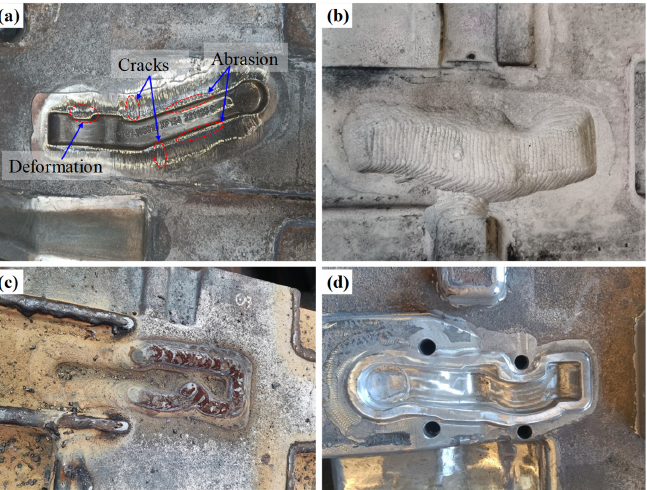
Figure 16. Production application of hot forging die remanufacturing: ( a ) the failed hot forging die; ( b ) removal of failure zone using carbon arc gouging; ( c ) wire and arc additive remanufacturing